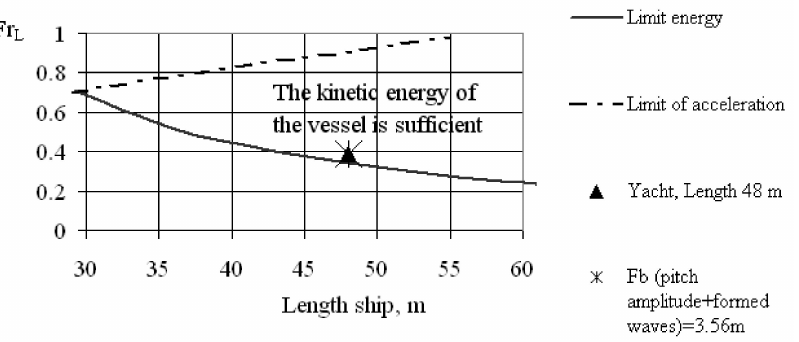
Figure 6. A comparison of the energies of the yacht (length 48 m) and the energy of a wave with a height h 3% = 4.5 m ( h 1/3 = 3.4 m).